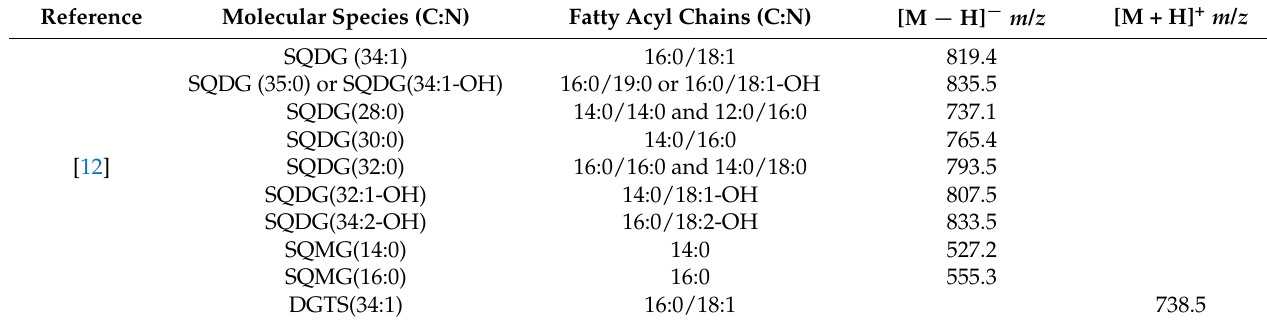
Table 3. List of glycoglycerolipid and betaine lipid molecular species identified in olive oil through mass spectrometry-based lipidomic